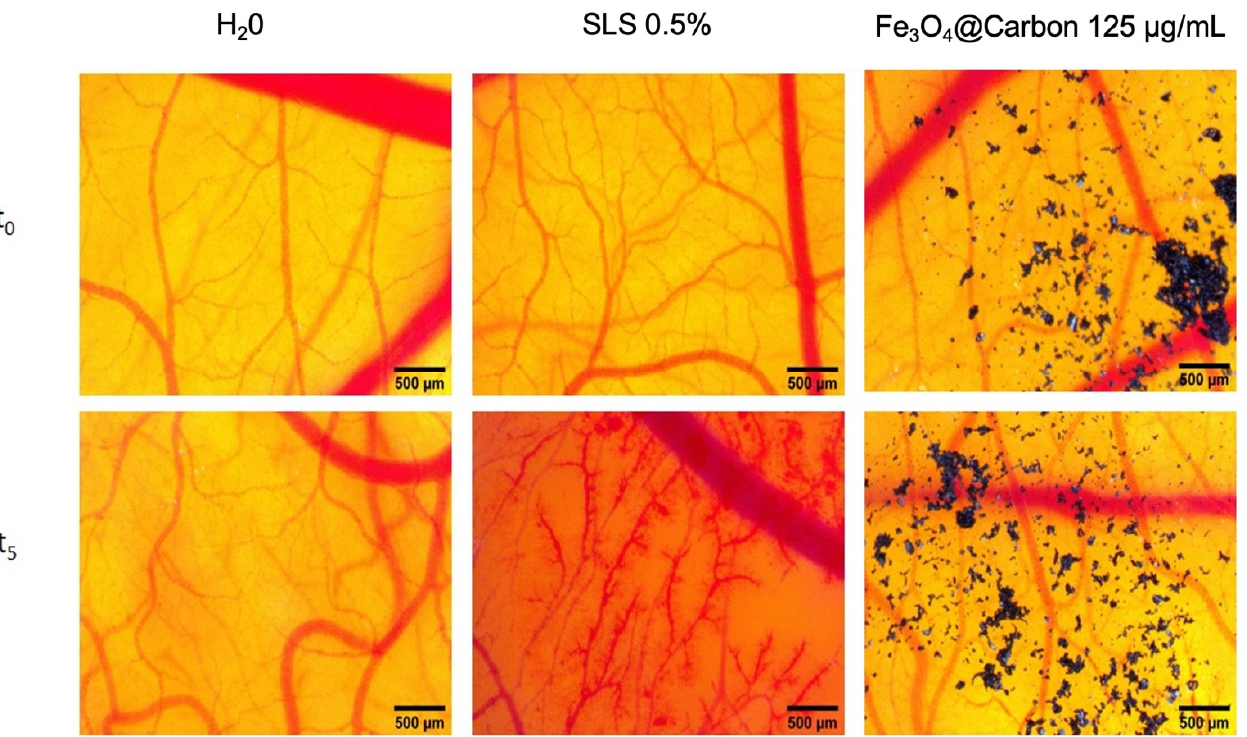
Table 2. Irritation score and type of effect induced by Fe 3 O 4 @Carbon nanoparticles at a concentra- tion of 125 µg/mL.